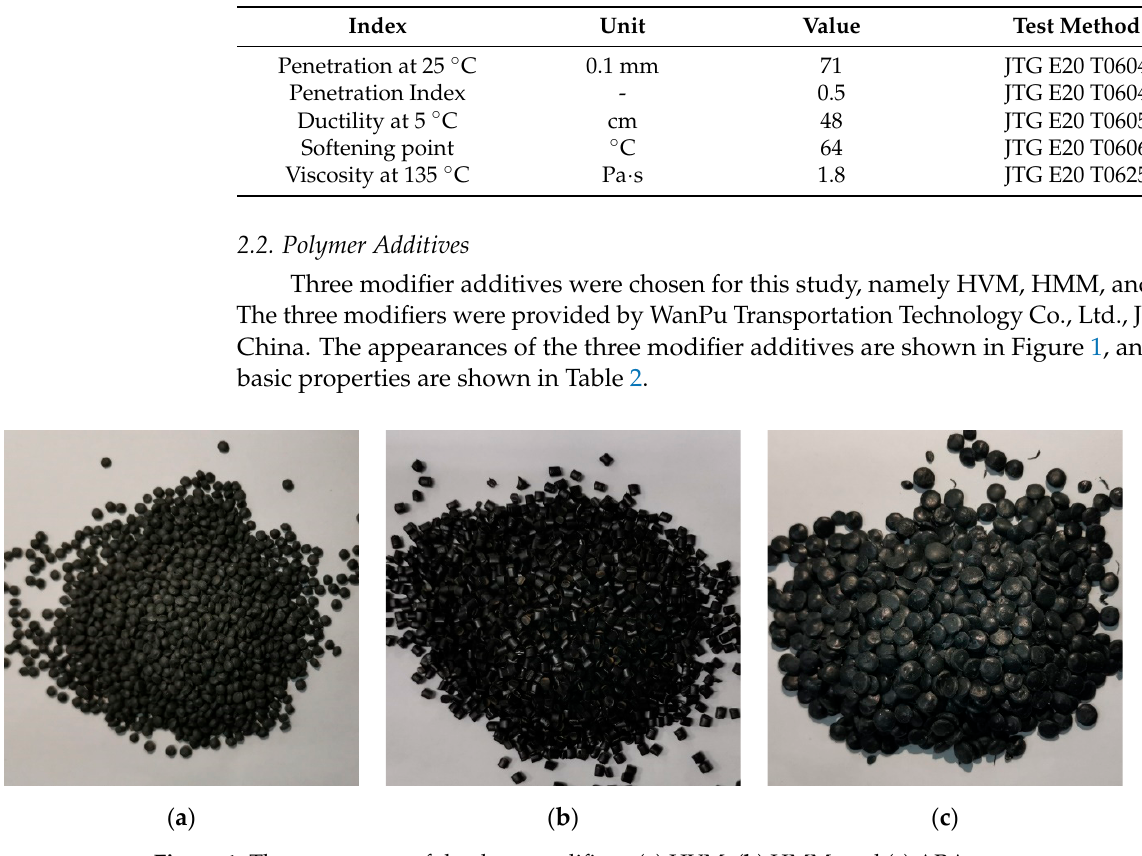
Figure 1. The appearance of the three modifiers: ( a ) HVM, ( b ) HMM, and ( c ) ARA. Table 2. Properties of modifiers.